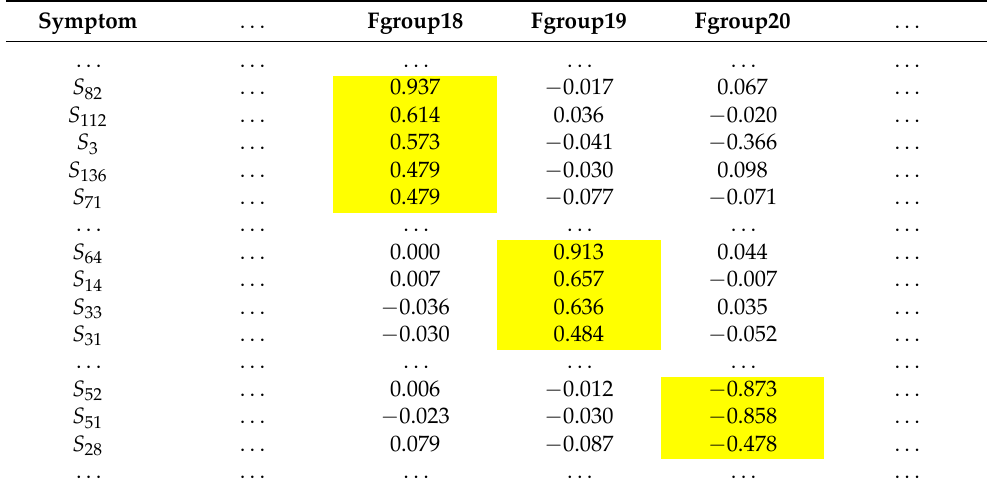
Table 3. Show Fgroup z with the feature loading weights of s c feature elements where each yellow cell is a feature loading weight of a s c feature element ≥ |0.4|.